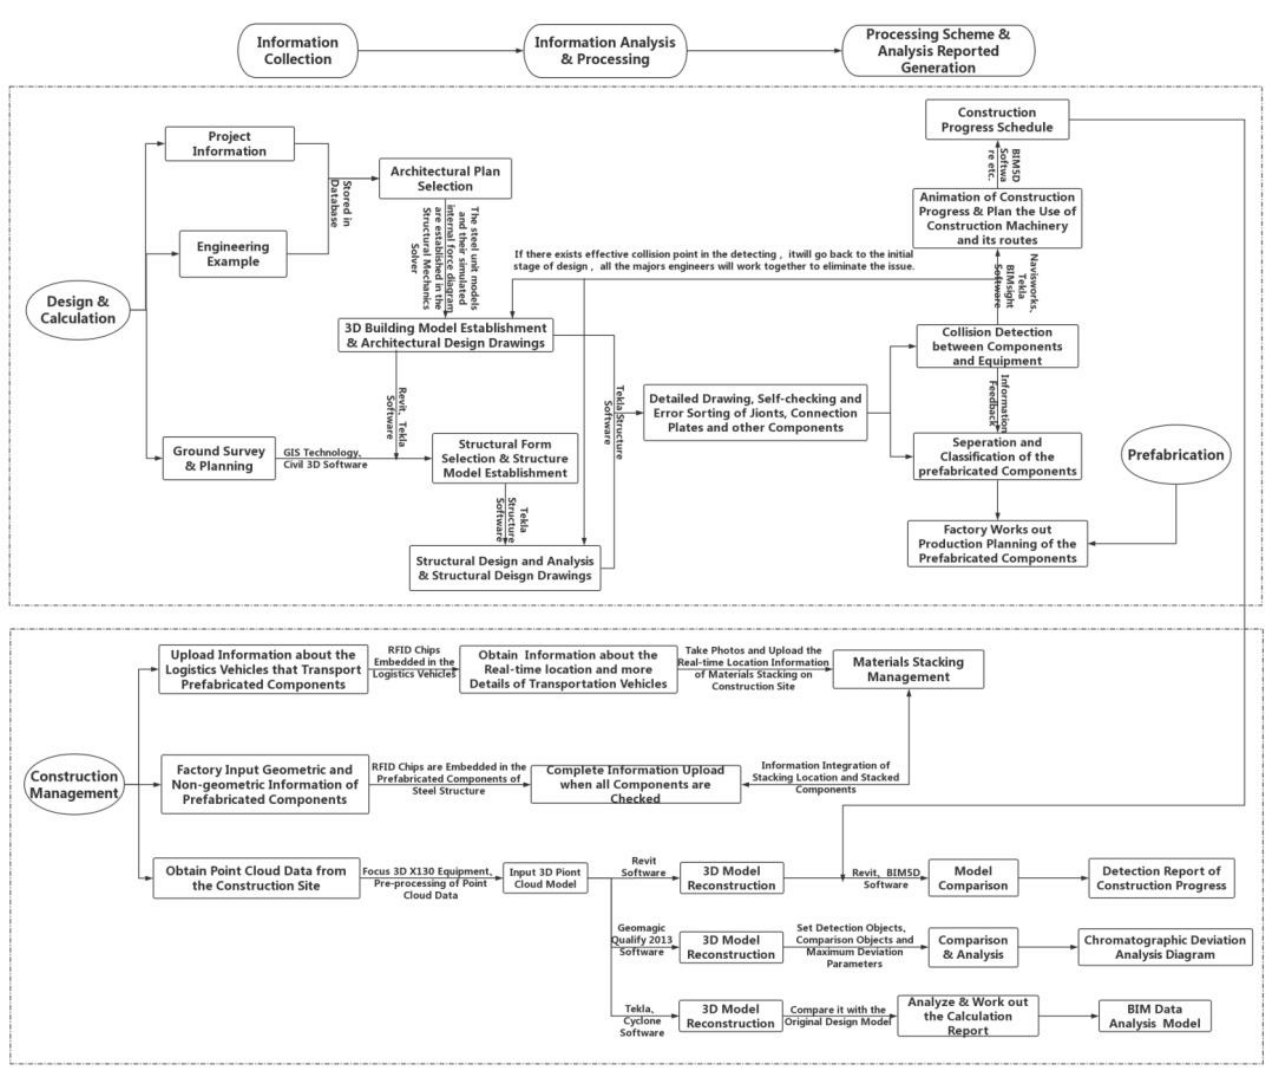
Figure 21 Implementation process of the design and construction method of the growable steel-unit Figure 21. structures.